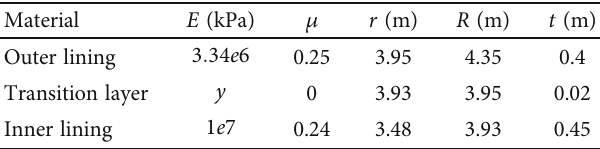
Figure 11: In fl uence of inner lining thickness on internal force and deformation of lining structure. Table 5: Calculation parameter